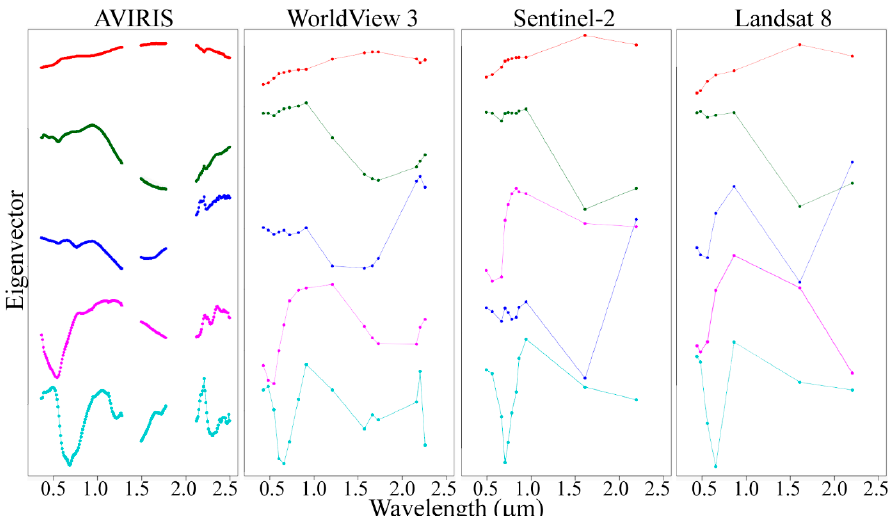
Figure A2. Eigenvectors. The first five dimensions for each sensor are shown, each shifted vertically by an arbitrary amount to avoid overlap. Colors are coordinated to indicate correspondence of spectral shape. WorldView 3 eigenvectors clearly demonstrate the same overall patterns as AVIRIS eigenvectors, at least through the first 5 dimensions. Eigenvectors for dimensions 3 and 4 appear to be swapped for Sentinel-2, possibly as a result of the loss of the additional SWIR bands. Landsat 8 eigenvectors for dimensions 3 and 4 appear to represent more complex mixtures of the eigenvectors for dimensions 3 and 4 for other sensors. Top row = Dimension 1, bottom row = Dimension